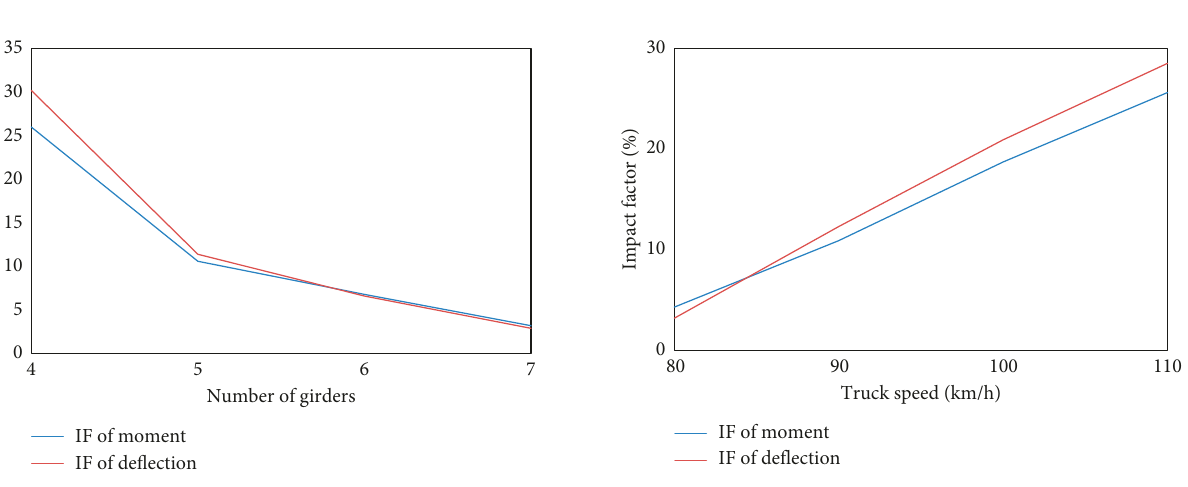
Figure 8: Number of girders versus the dynamic impact factor for Bridge A-10.